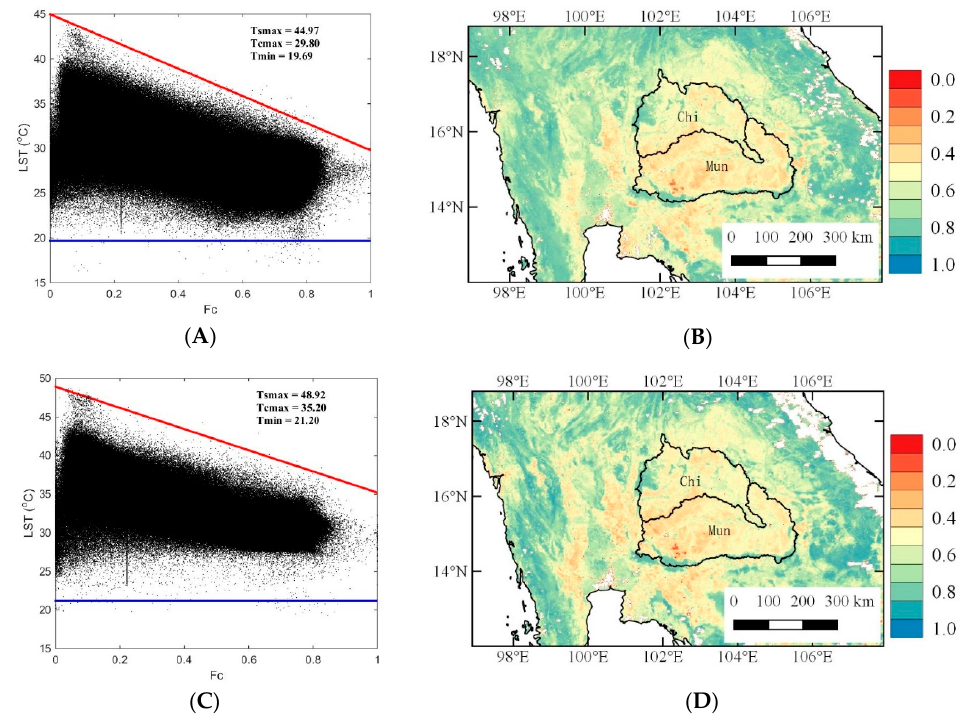
Figure 5. Example of LST-VI triangle scatterplot ( A , C ) and the spatial variation of estimated EF ( B , D ), by Terra ( A , B ) and Aqua Moderate Resolution Imaging Spectroradiometer (MODIS) ( C , D ) at January 20 of 2009. Red line in the LST-VI triangle scatter is the dry edge where φ =1.26 × Fc , while the blue line is the wet edge where φ = 1.26.